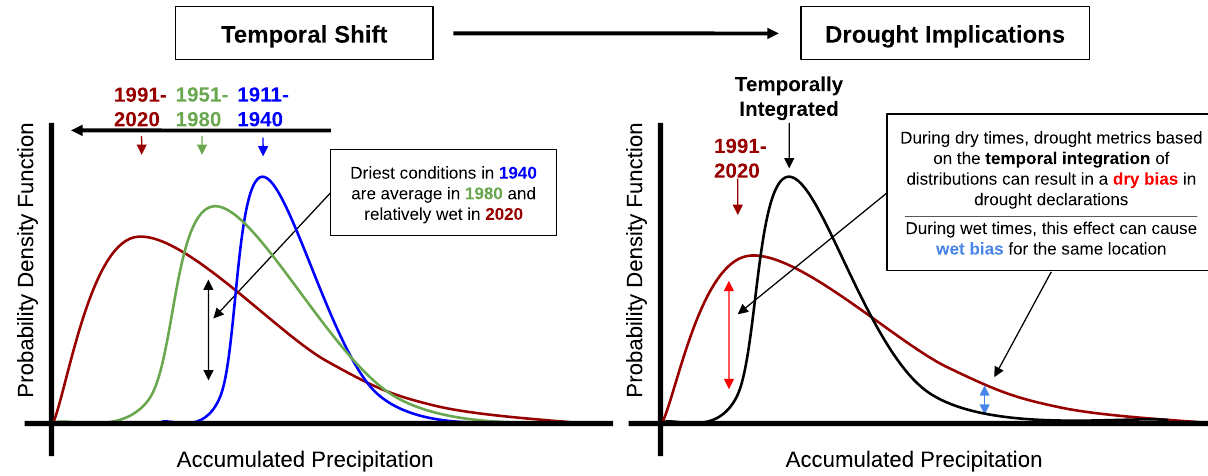
Fig. 1 Conceptual model describing the drought metric bias associated with a non-stationary climate scenario. A theoretical accumulated precipitation dataset is presented on the horizontal axis, while the associated probability density function (PDF) is on the vertical axis. [left] Conceptual model showing one way that probability distributions can shift in time when conditions transition from a wetter, less variable state to a drier, more variable state. [right] Demonstration of how this shift can produce both a dry bias during dry times and a wet bias during wet times for a theoretical